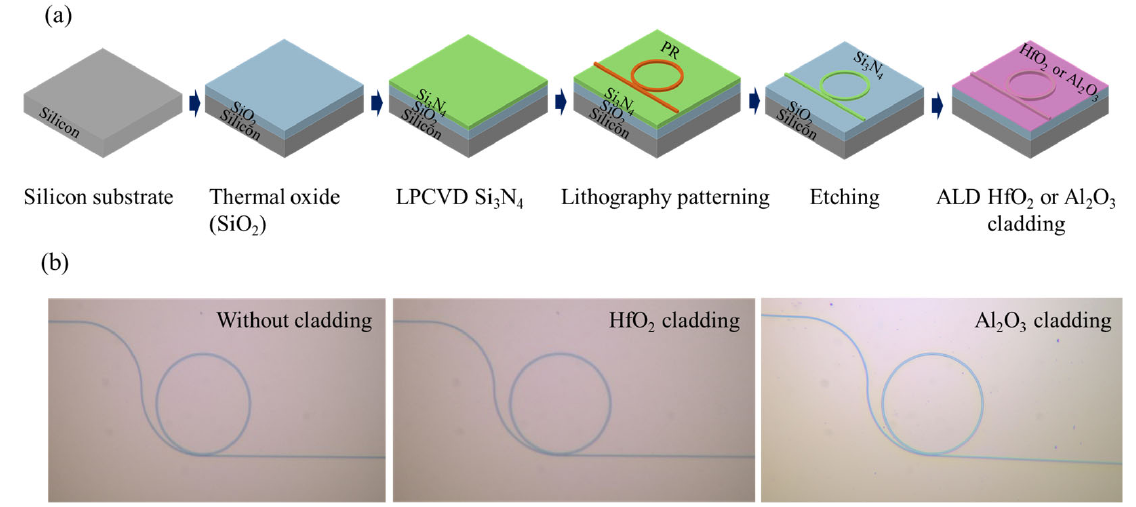
Figure 2. ( a ) Schematics of fabrication processes and ( b ) images of the fabricated devices without and with the ALD cladding.